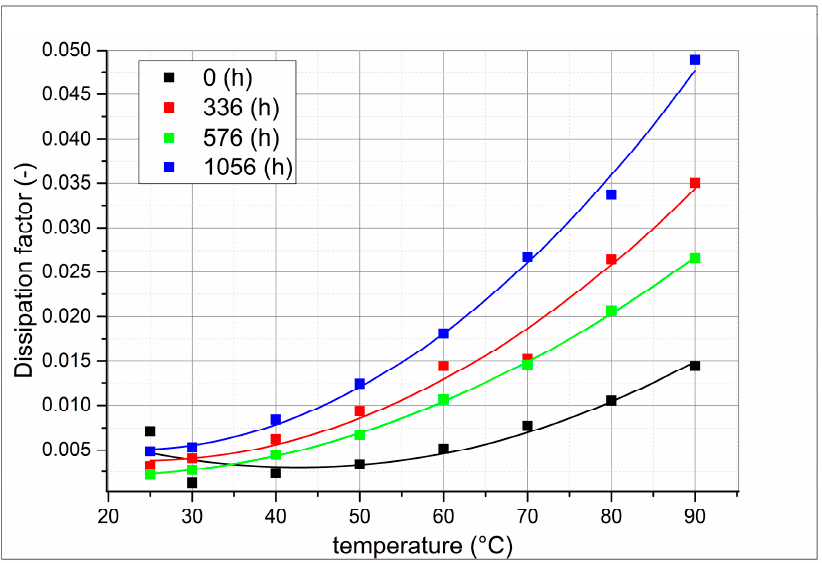
Figure 3. Thermal dependency of the dissipation factor of rapeseed oil at 140 °C exposure for different exposure times.